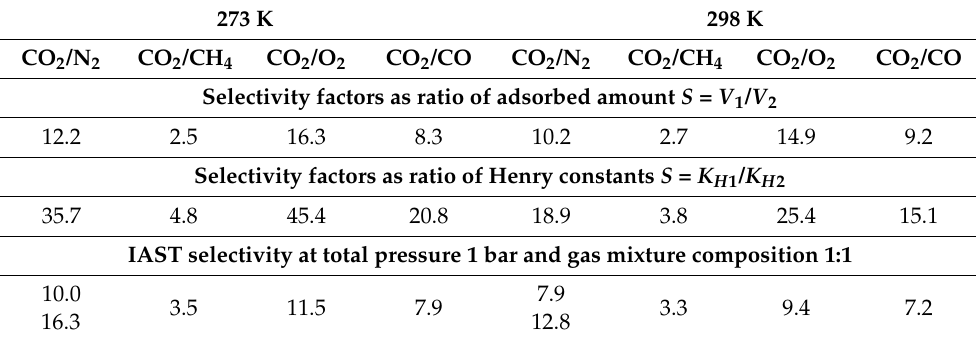
Table 2. Selectivity factors for separation of binary gas mixtures evaluated by different